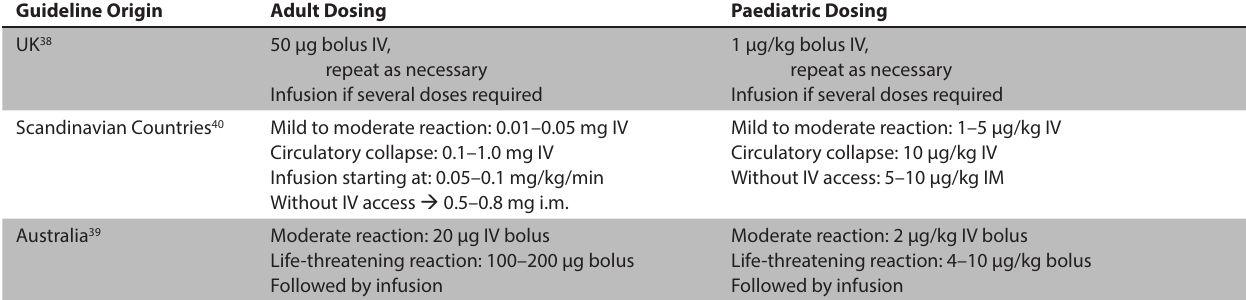
Table 7: Summary of Adrenaline Dosing Guidelines for Perioperative Anaphylaxis Guideline